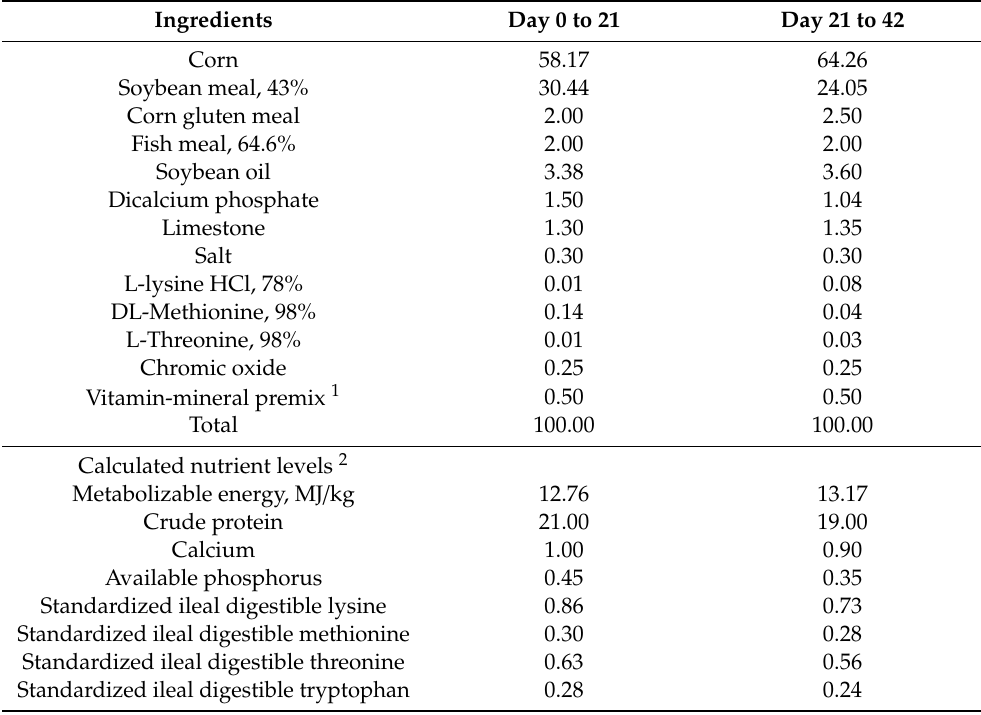
Table 1. Composition and nutrient levels of basal diets (%, as-fed